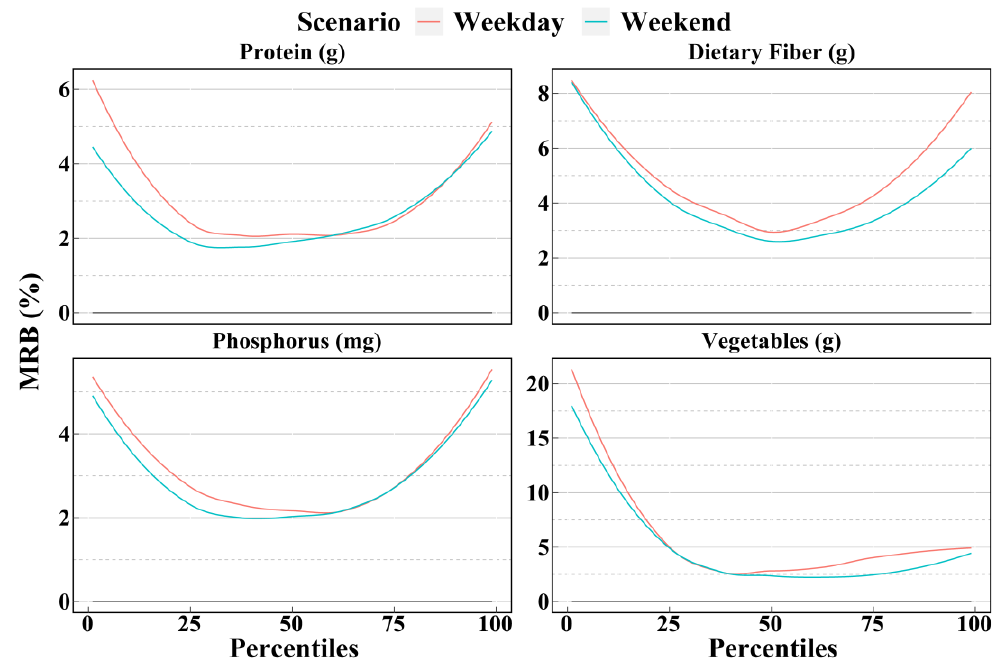
Figure 7. Smooth curves of the percentile (from 1st to 99th) intakes of dietary components in group 1 estimated by weekday and weekend of scenario NC2 based on the NCI method. Smooth curves of the bias and relative bias for each dietary component in group 1 as calculated by the four scenarios are available in Supplementary Figure S5. Weekday = Two non-consecutive weekdays; Weekend = Of the two non-consecutive days, one was a weekend, and the other was a weekday; MRB = Mean relative bias.